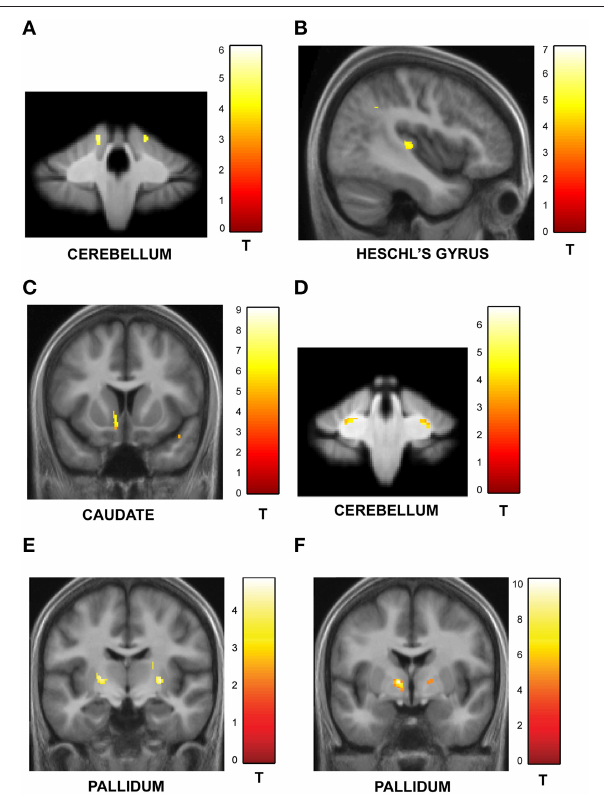
FIGURE 5 | Structural imaging results: correlation between GM and WM volume and behavior. All activations are reported at a threshold of p < 0.001 (uncorrected) and scaled according to the t- value maps on the right. (A) Correlation between GM volume and performance on irregular sequences. The GM volume in the cerebellum increased with precision on irregular trials as shown here. Similar effects were observed in the orbitofrontal cortex and inferior temporal gyrus (Table S1A). (B) Correlation between GM volume and performance on regular sequences. The gray matter volume of sensory areas in Heschl’s gyrus increased as a function of precision on regular sequences as shown here. Similar effects were also observed in the STG, insula and middle cingulate gyrus (Table S1B). (C) Correlation between GM volume and performance on sequences with high memory load. The gray matter volume of the caudate increased with performance on sequences with greater memory load. Correlations were also observed in the insula, thalamus and the Heschl’s gyrus (as listed in Table S2A). (D) Correlation between GM volume and performance on sequences with low memory load. The cerebellum showed higher GM volume as a function of precision on sequences with low memory load (see Table S2B). (E) Correlation between WM volume and performance on irregular sequences. The pallidum expressed higher WM volume that correlated with listeners’ precision as a function of increasing irregularity of